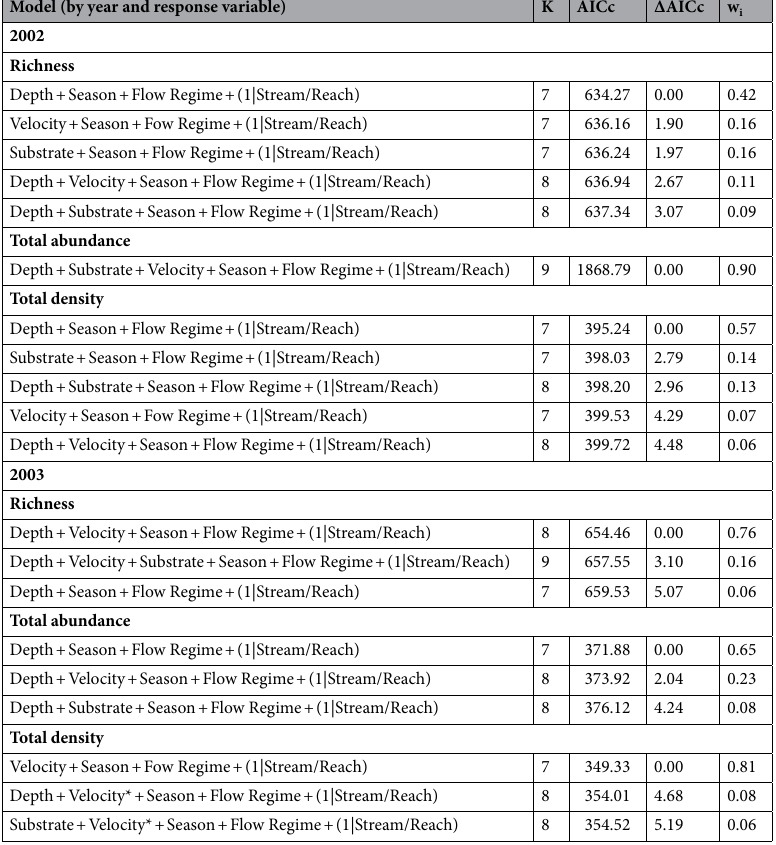
(Table 3). Species richness was positively related to depth and negatively related to current velocity (Table 4). The best model for total fish abundance was the depth model in 2003 (Table 3), with depth being positively related to total abundance (Table 4). The best model for total fish density was the current velocity model in 2003 (Table 3), with velocity being negatively related to total density (Table 4). No response variable showed a significant rela- tionship with season or flow regime in 2003 (Table 4). Species turnover (proportion of species differing between time points) varied by year and assemblage stabil- ity (temporal mean divided by temporal standard deviation) varied by year and flow regime. Species turnover showed no two- or three-way interactions among flow regime, season and year (ANOVA p > 0.05). There was a strong year effect with species turnover significantly greater in 2002 than 2003 (ANOVA p = 0.001, Fig. 5). Assem- blage stability showed a marginal flow regime by year interaction (ANOVA p = 0.053; Fig. 6). Assemblage stability was significantly lower in 2002 than 2003 in Runoff/Intermittent Flashy streams (ANOVA p = 0.049), but did not differ between years in Groundwater Flashy streams (ANOVA p = 0.374; Fig. 6). In 2002, assemblage stability was significantly lower in Runoff/Intermittent Flashy than Groundwater Flashy streams (ANOVA p = 0.003), whereas in 2003 the two flow regimes did not differ significantly in assemblage stability (ANOVA p = 0.537; Fig. 6). Redundancy analysis showed a significant relationship between fish species densities and explanatory vari- ables in both 2002 (Monte Carlo p = 0.001) and 2003 (Monte Carlo p = 0.001). There was seasonal change in fish assemblage structure (species composition and relative density) that appeared to be driven largely by changes in fish species densities. Fish assemblages showed a separation between flow regimes in 2002 along RDA axis 2 and in 2003 along RDA axis 1 (Fig. 7). In both years, there were greater densities of central stonerollers, creek chubs, whitetail shiners and slender madtoms in Runoff/Intermittent Flashy streams and greater densities of banded sculpins, hornyhead chubs and lampreys in Groundwater Flashy streams (Fig. 7). Southern redbelly dace were abundant in Groundwater Flashy streams, but they were also found in high numbers in Cave Creek, an Intermittent Flashy stream. The other strong pattern found in the RDA ordinations was the seasonal shifts in fish species densities driven by strong increases in densities of the common fish species from spring through autumn, especially in Runoff/Intermittent Flashy streams. In 2002, autumn differed most from the other seasons, with particularly high relative fish densities in Bear and Cave Creeks (Fig. 7). In 2003, there was a strong change in fish species densities in Bear Creek along RDA axis 1 and Cave Creek along RDA axis 2 (Fig. 7). Opportunistic, Opportunistic/Equilibrium and Equilibrium species were characteristic of both stream types. Periodic and opportunistic species were characteristic of Runoff/Intermittent Flashy streams, whereas mainly